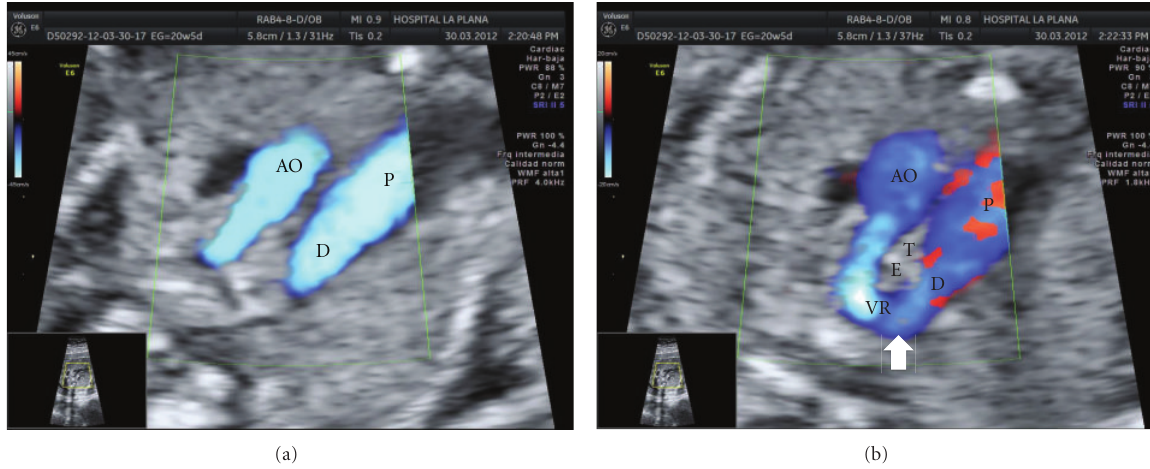
Figure 1: (a) Color Doppler ultrasound (three vessels and trachea view) showing two parallel vessels. This was the first clue to the diagnosis of cardiac malformation and subsequent fetal aneuploidy. AO: aortic arch, P: pulmonary vein, D: ductus arteriosus. (b) Color Doppler ultrasound showing a vascular retroesophageal ring formed with the union of the right aortic arch and the prolongation of the ductus arteriosus. As the aortic arch passes over the right bronchus, the encounter between both circulations occurs behind the esophagus. AO: aortic arch, P: pulmonary vein, D: ductus arteriosus, VR: vascular ring, T: trachea, E: esophagus. In the union of the ductus arteriosus and the aortic arch a small outpouching is seen forming a small diverticulum of Kommerell (arrow), where the aberrant left subclavian artery (not seen in this picture) joined.